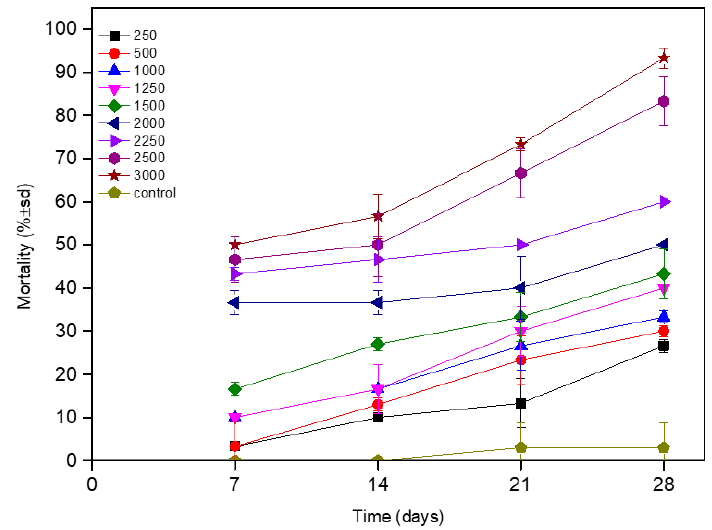
Figure 3. Mean mortality (% ± SD) of A. diaperinus adults sprayed with six concentrations of cyantraniliprole after 28 days.